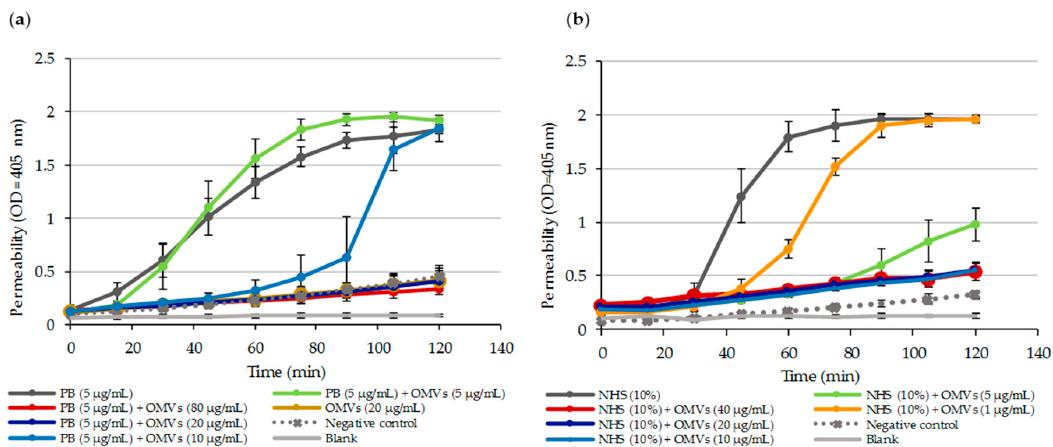
Figure 5. OMVs block the permeabilizing activity of membrane targeting agents . Change in E.coli ML-35p membrane permeability was assayed by a time-dependent influx of ONPG in the presence of membrane-targeting agents and different concentrations of Mc6 OMVs . Bacteria at log phase ( ∼ 10 6 cfu/mL) were incubated on microplate at 37 °C for 120 min in the presence of indicated concentrations of OMVs together with ( a ) polymyxin B (PB) and ( b ) normal human serum (NHS). The absorbance was measured at indicated time points. The results are shown as mean ± SD from at least three independent experiments performed in duplicate.